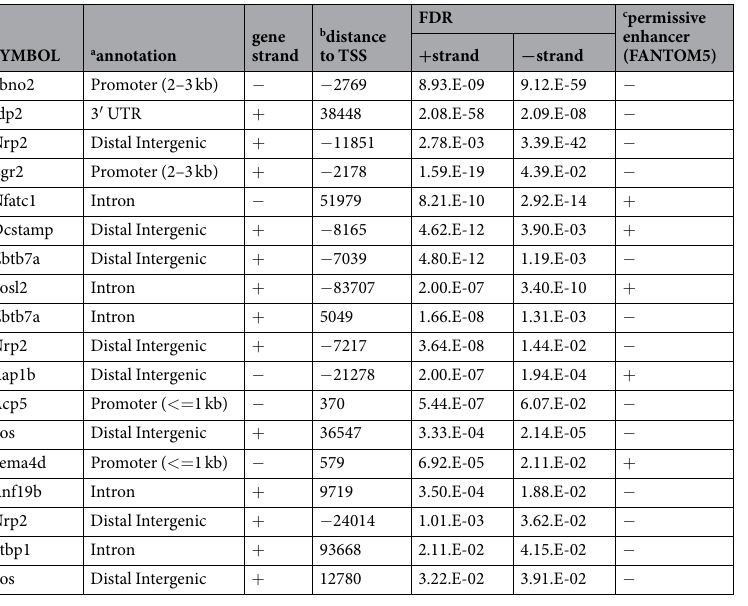
Table 1. List of candidate eRNA regions in response to RANKL stimulation. a Annotation of gene segments defined by edgeR. b The distance to the transcription start site (TSS) measured from the TSS of protein-coding measured by edgeR. c The enhancer regions were classified into robust and permissive, based on the read counts. The permissive enhancer was defined by FANTOM5 mouse permissive enhancer phase 1 and 2 23